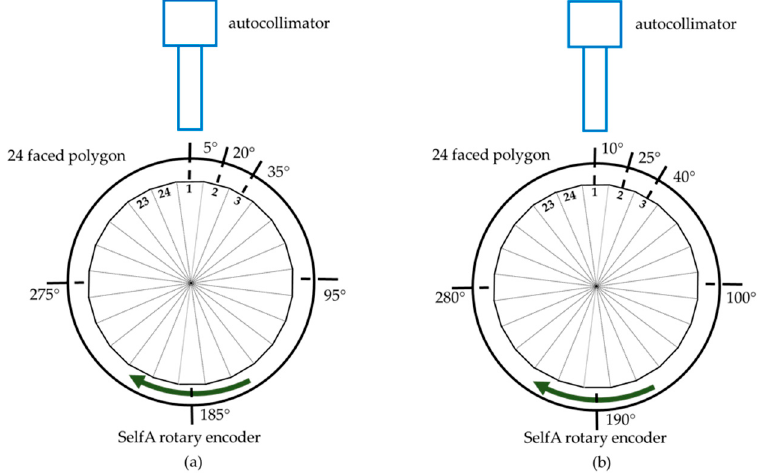
Figure 8. Shift-angle method for SelfA rotary encoder at different shift-angles. ( a ) S = 5 ° . ( b ) S = 10 ° .